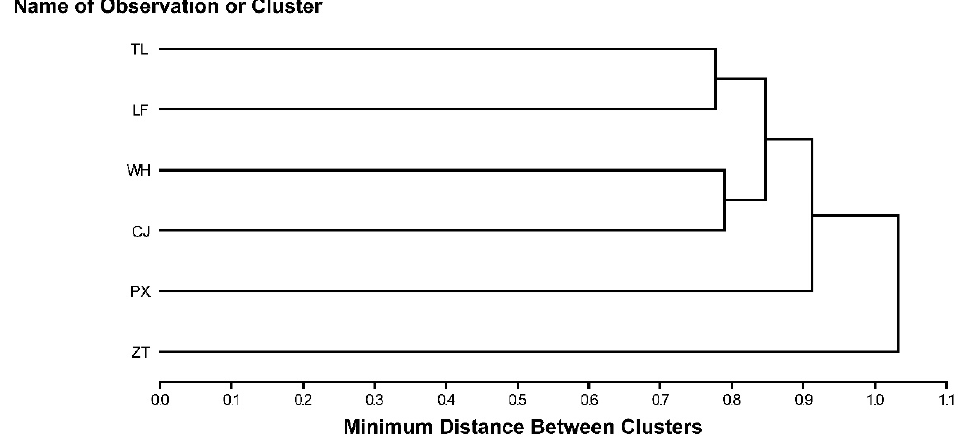
Figure 2. Clustering for weathered coal samples from different geographical locations using the single linkage method.